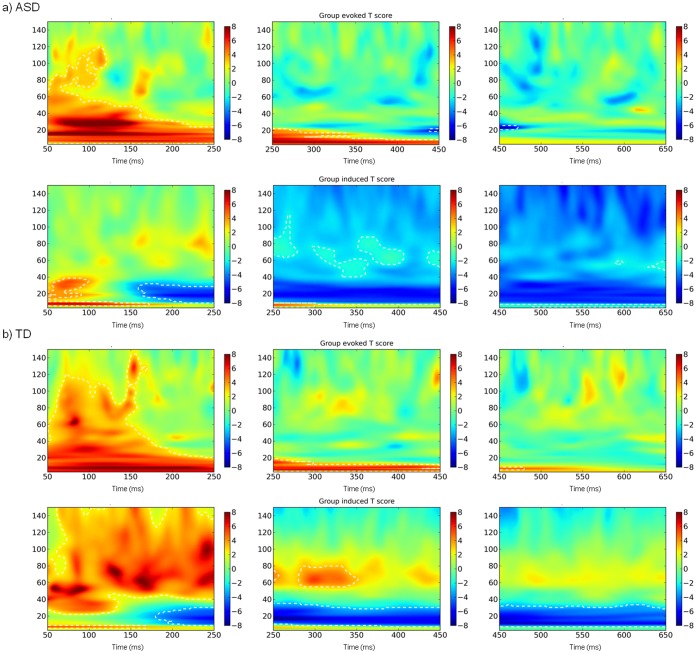
Virtual electrode responses in the right lateral occipital cortex, superior division (R-LOP; 36, −86, 2) for ASD (a) and TD (b) participants.Evoked responses are displayed in the upper row of each figure; induced responses are displayed in the lower row. All responses indicate within subjects changes from baseline; changes significant at p<.05 level are indicated within dotted lines.